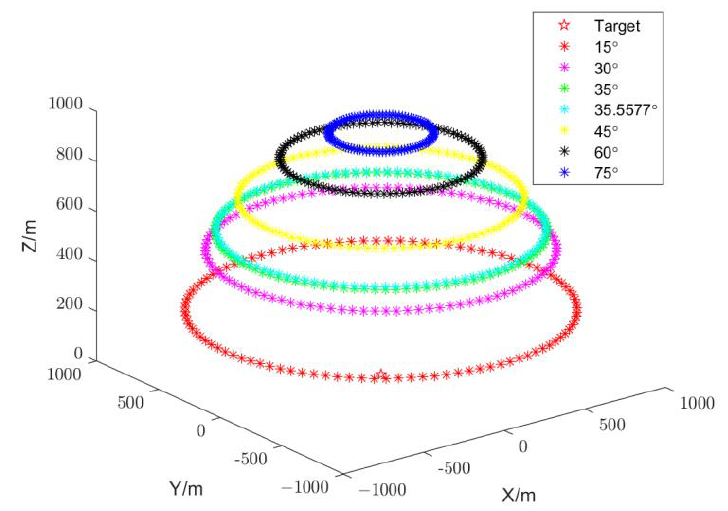
Figure 5. Schematic diagram of multi-stations positioning deployment.